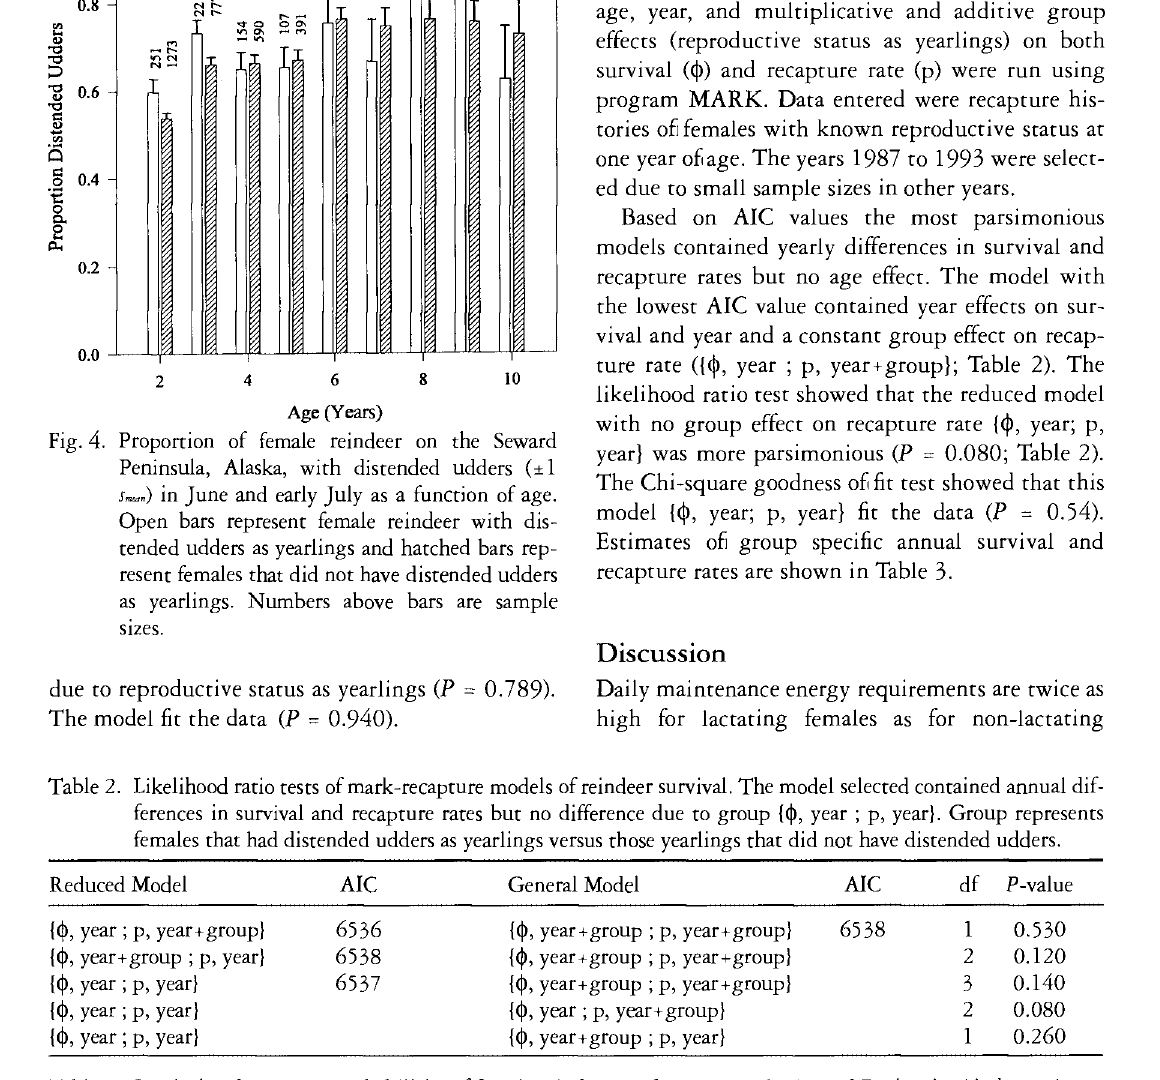
Table 3. Survival and recapture probabilities of female reindeer age 1 + years on the Seward Peninsula, Alaska, estimat ed from the model with year and group specific survival rates and recapture rates {(|), year*group; p, year*group(. + indicates females that had distended udders as yearlings, - indicates females that did not have distended udders as